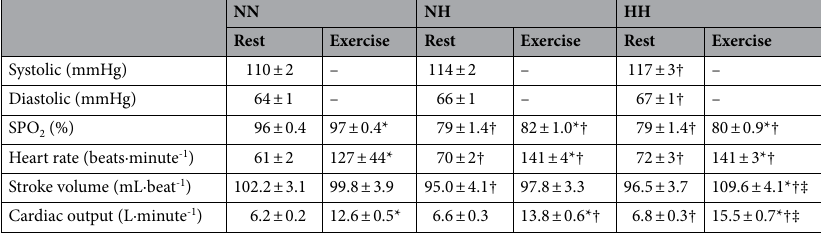
than NH ( p = 0.224) (Table 1). Resting cardiac output during the NH exposure was not significantly different than NN ( p = 0.125) (Table 1). Cardiac output during exercise was significantly higher than at rest within each